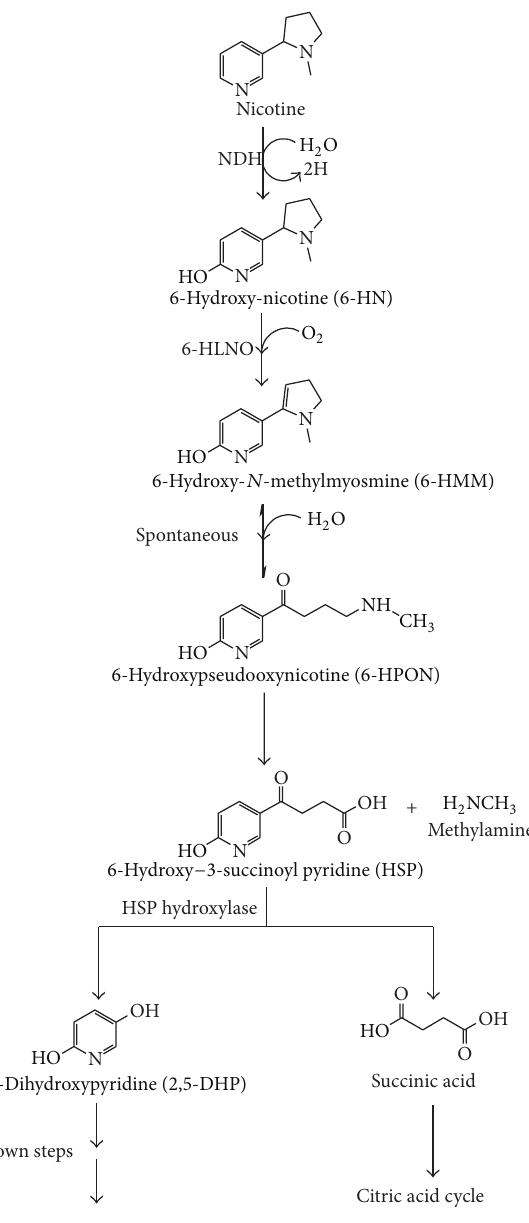
Figure 4: A variant of pyridine and pyrrolidine pathway of nicotine degradation by A. tumefaciens S33. NDH, nicotine dehydroge- nase; 6-HLNO, 6-hydroxy-L-nicotine oxidase; HSP hydroxylase, 6- hydroxy-3-succinoyl pyridine